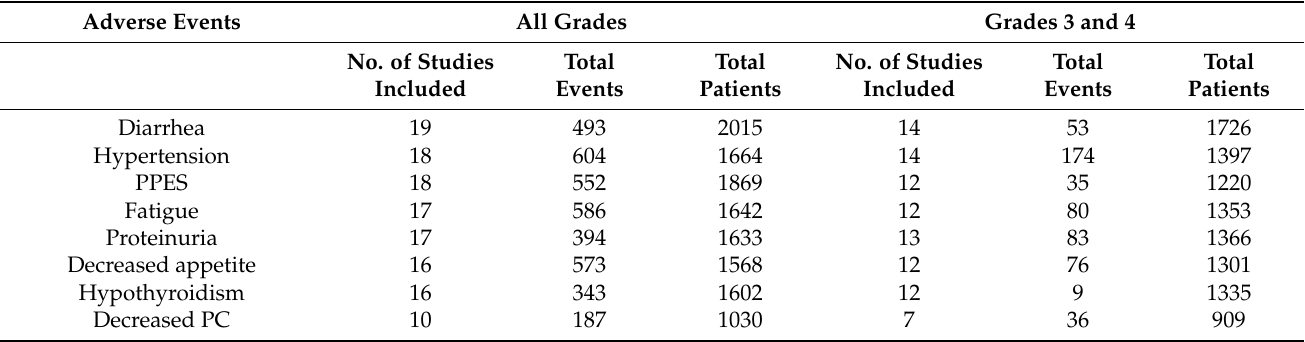
Table 2. Adverse events of lenvatinib in patients with unresectable hepatocellular carcinoma. Adverse Events All